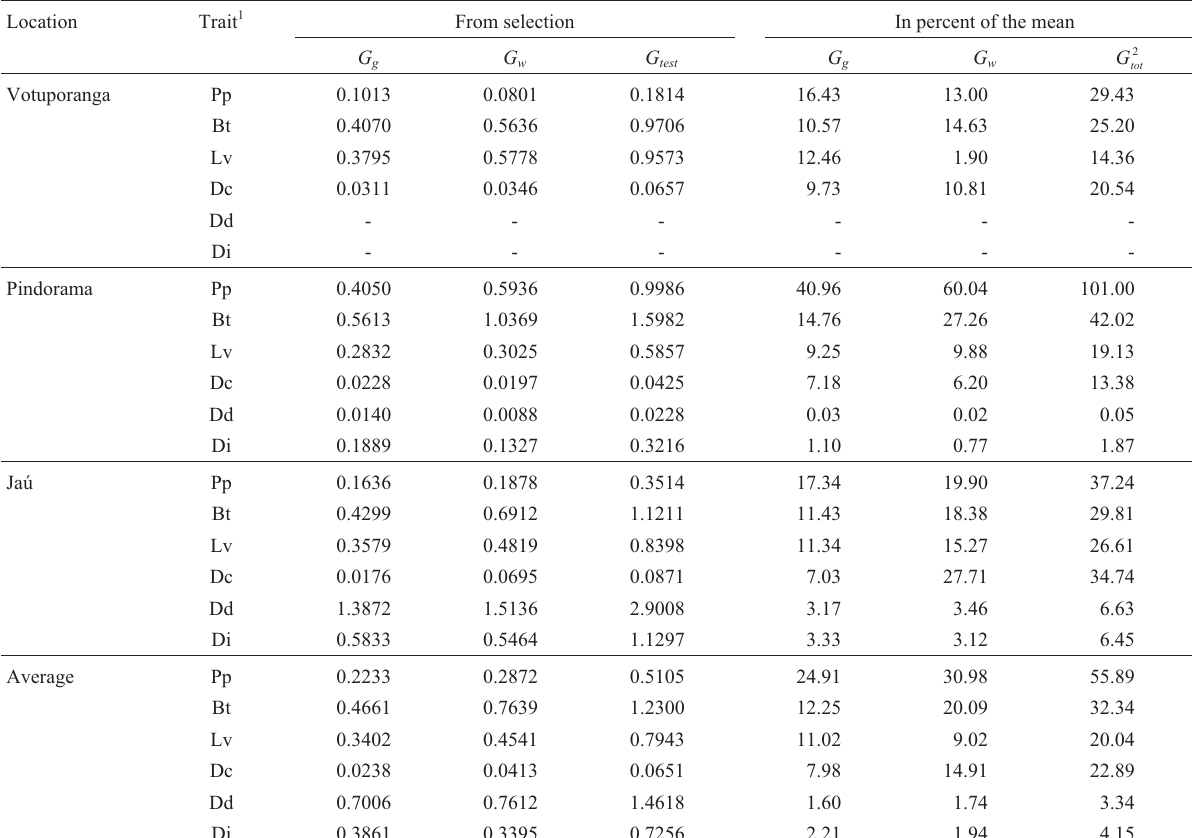
g )within( G w )progeniesandtotal( G test )forsixdifferenttraitsofthe